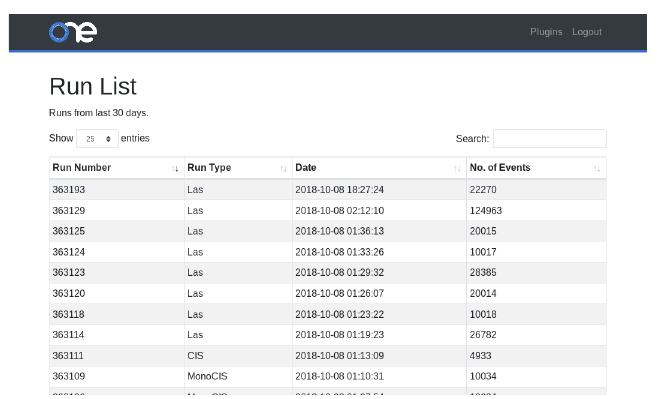
Figure 8. Screenshot of a regular plugin in new Tile-in-One platform called Run